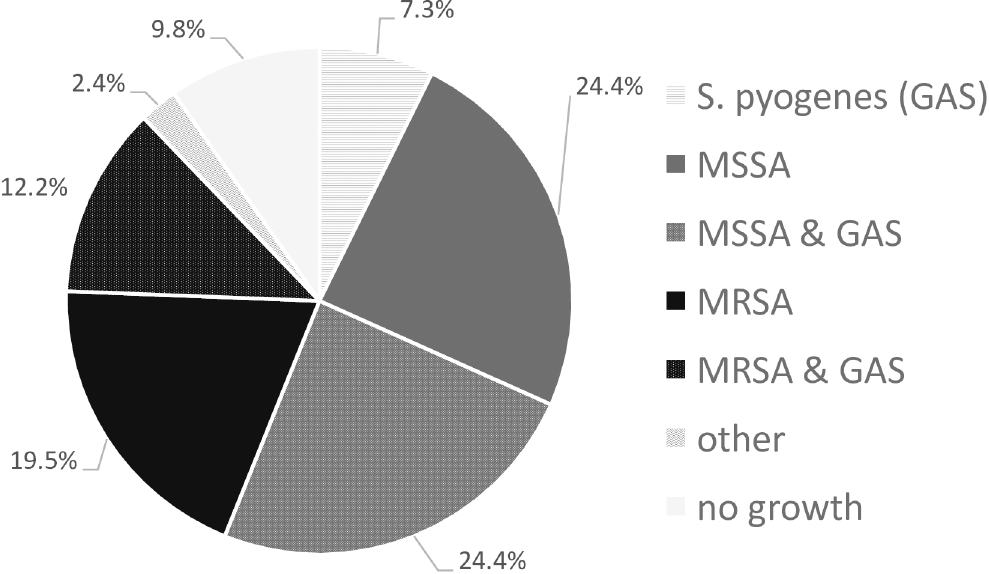
Fig 2. Impetigo microbiology. The figure representsa total of 41 culture positive microbiological samples from prospectively assessed patients with crusted or purulentimpetigo.